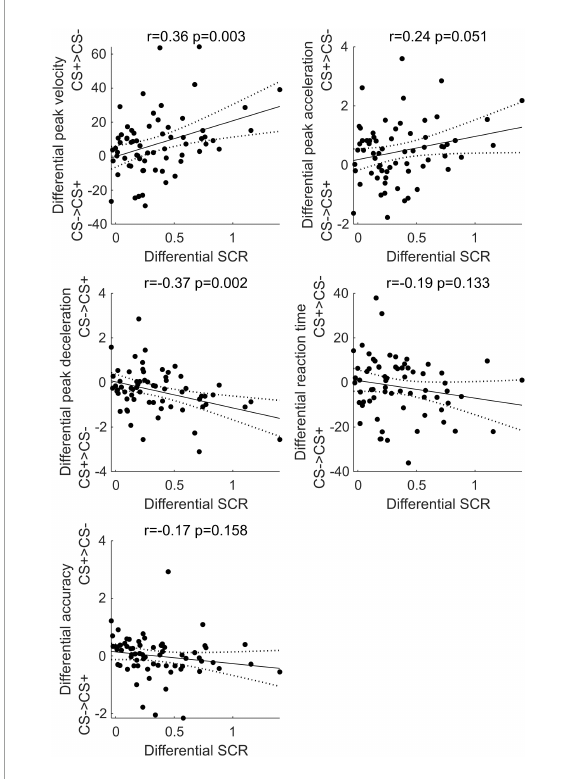
FIGURE7 Simple linear correlation between the difference in skin conductance response between CS+ and CS– during threat learning and the difference in peak velocity, acceleration, deceleration, reaction time, and accuracy between CS+ and CS– at test. Black dots represent individual participants’ data points, the black line represents the correlation line, dashed lines represent 95% confidence intervals. Pearson’s r and p -values are